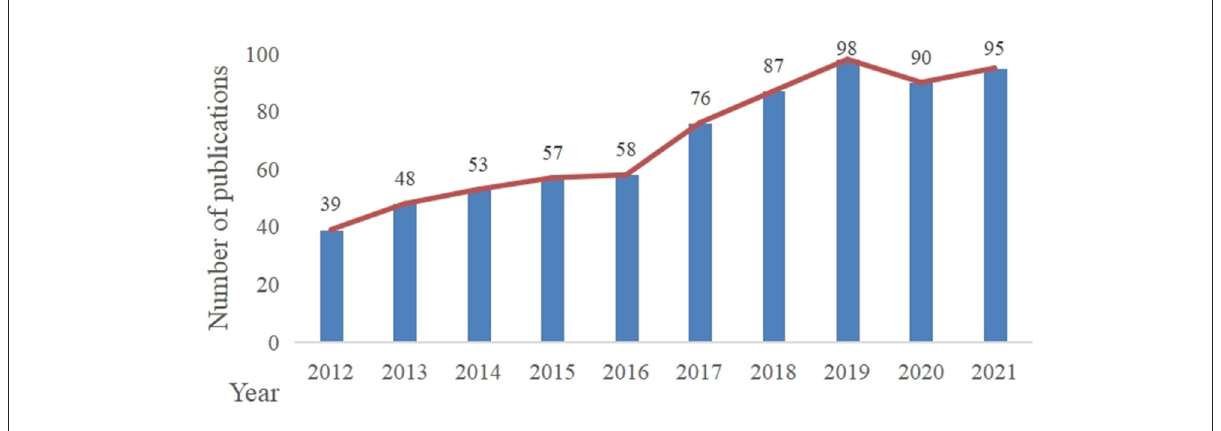
FIGURE1 The number of annual publications from 2012 to 2021 in this